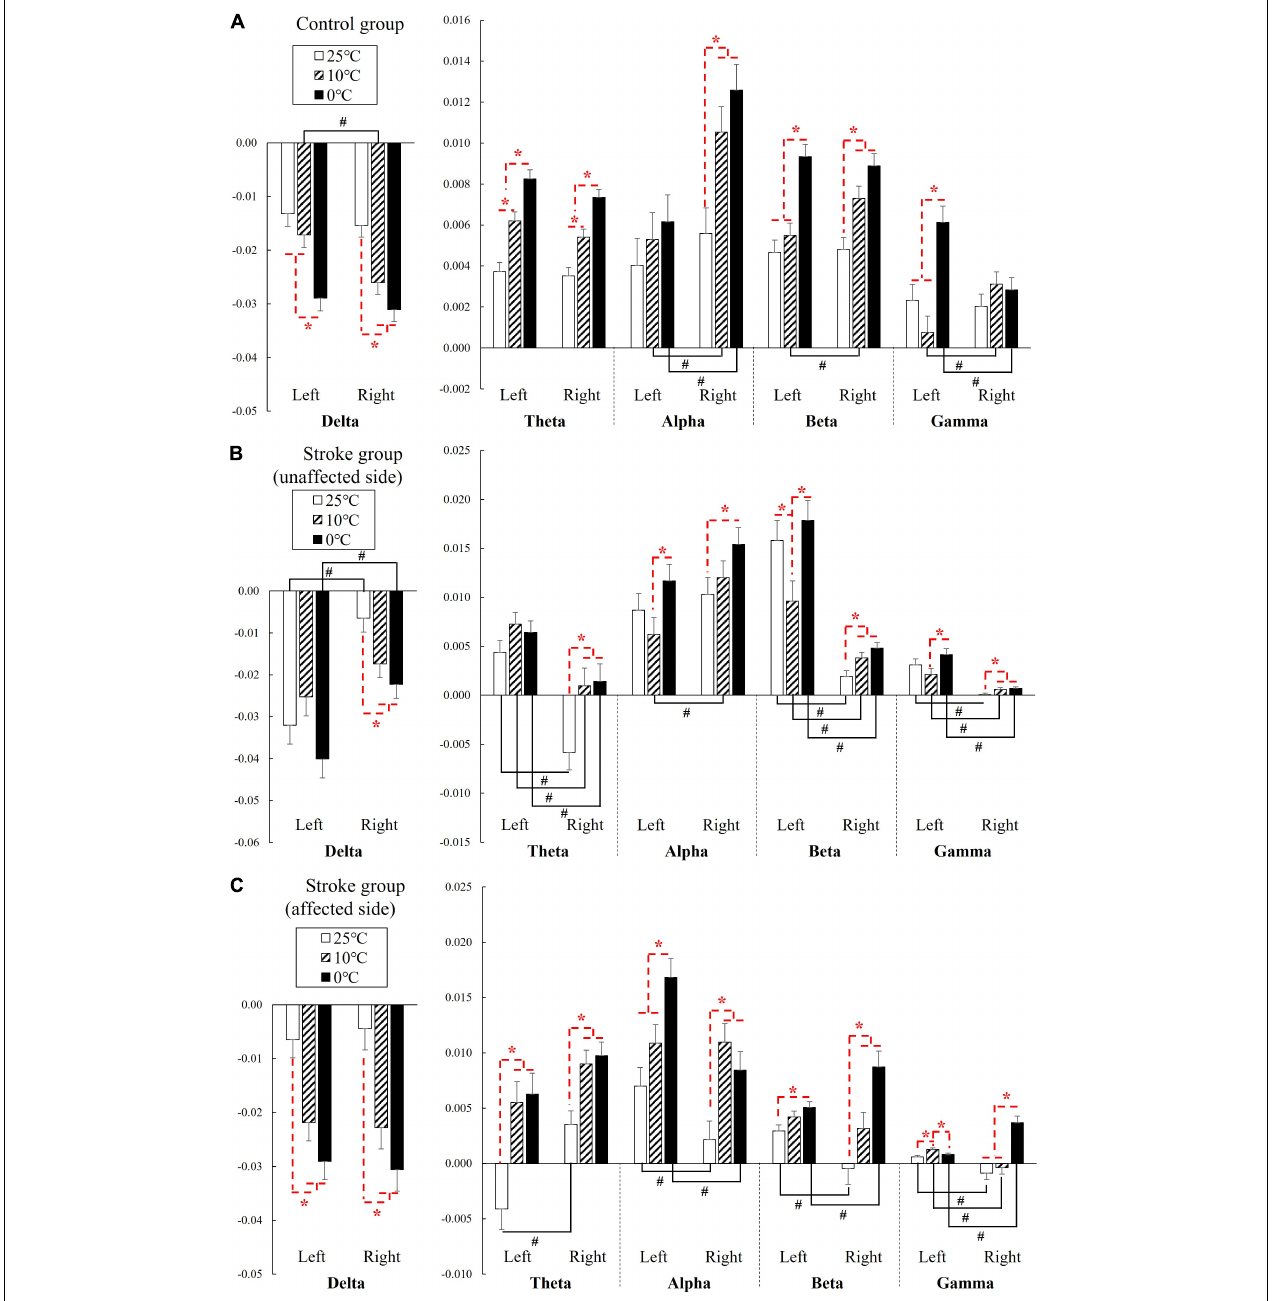
FIGURE 3 | The EEG relative spectral power in response to the NPCSs on the left and right forearms for (A) control group, (B) stroke group-unaffected side, and (C) stroke group-affected side on the whole brain at the delta, theta, alpha, beta, and gamma band presented as mean value with SE (error bar). The significant intragroup differences are indicated by “*” ( p < 0.05, one-way repeated ANOVA with Bonferroni post-hoc tests), and the significant intergroup differences are indicated by “#” ( p < 0.05, independent t -test).